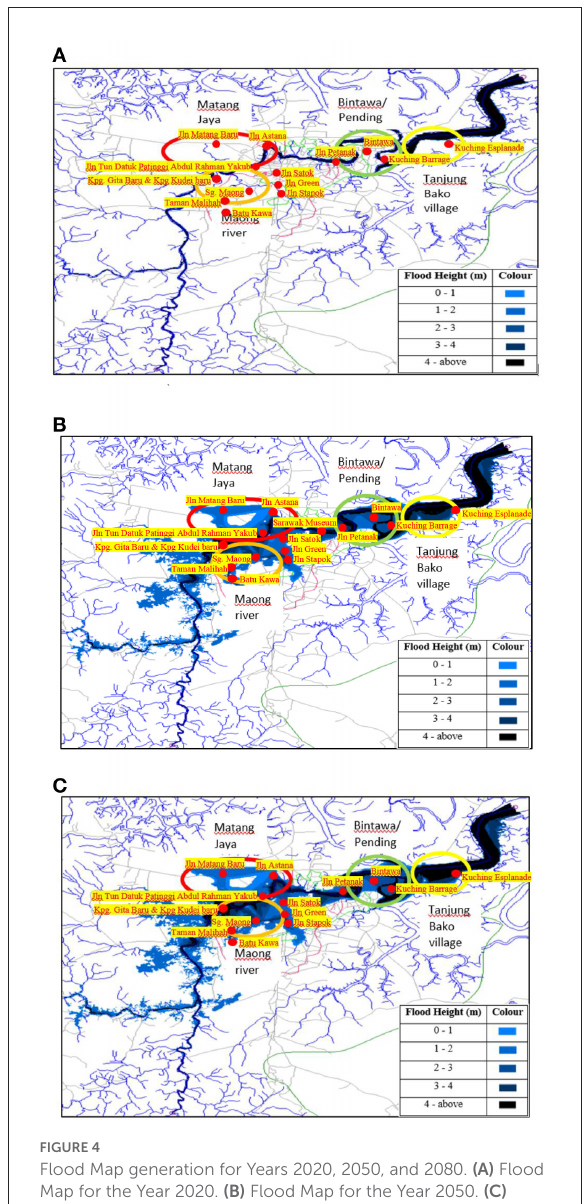
FIGURE4 Flood Map generation for Years 2020, 2050, and 2080. (A) Flood Map for the Year 2020. (B) Flood Map for the Year 2050. (C) Flood Map for the Year 2080.